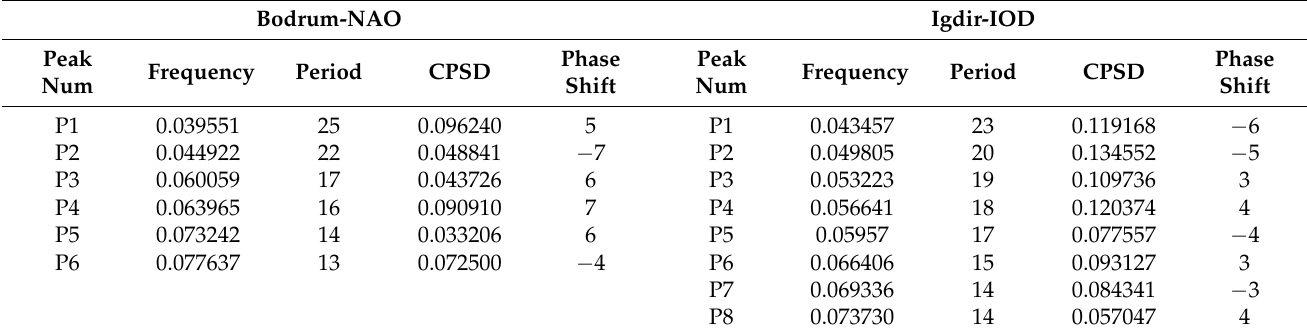
Table 2. Frequency, period, CPSD, and phase shift values of the peaks from Figure 12.